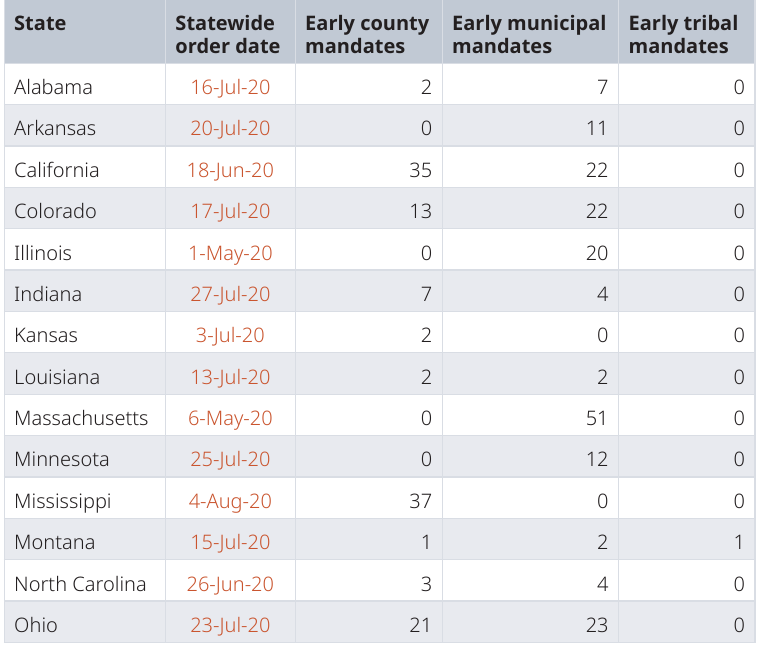
Table 1. Local government mask orders preceding statewide orders by US